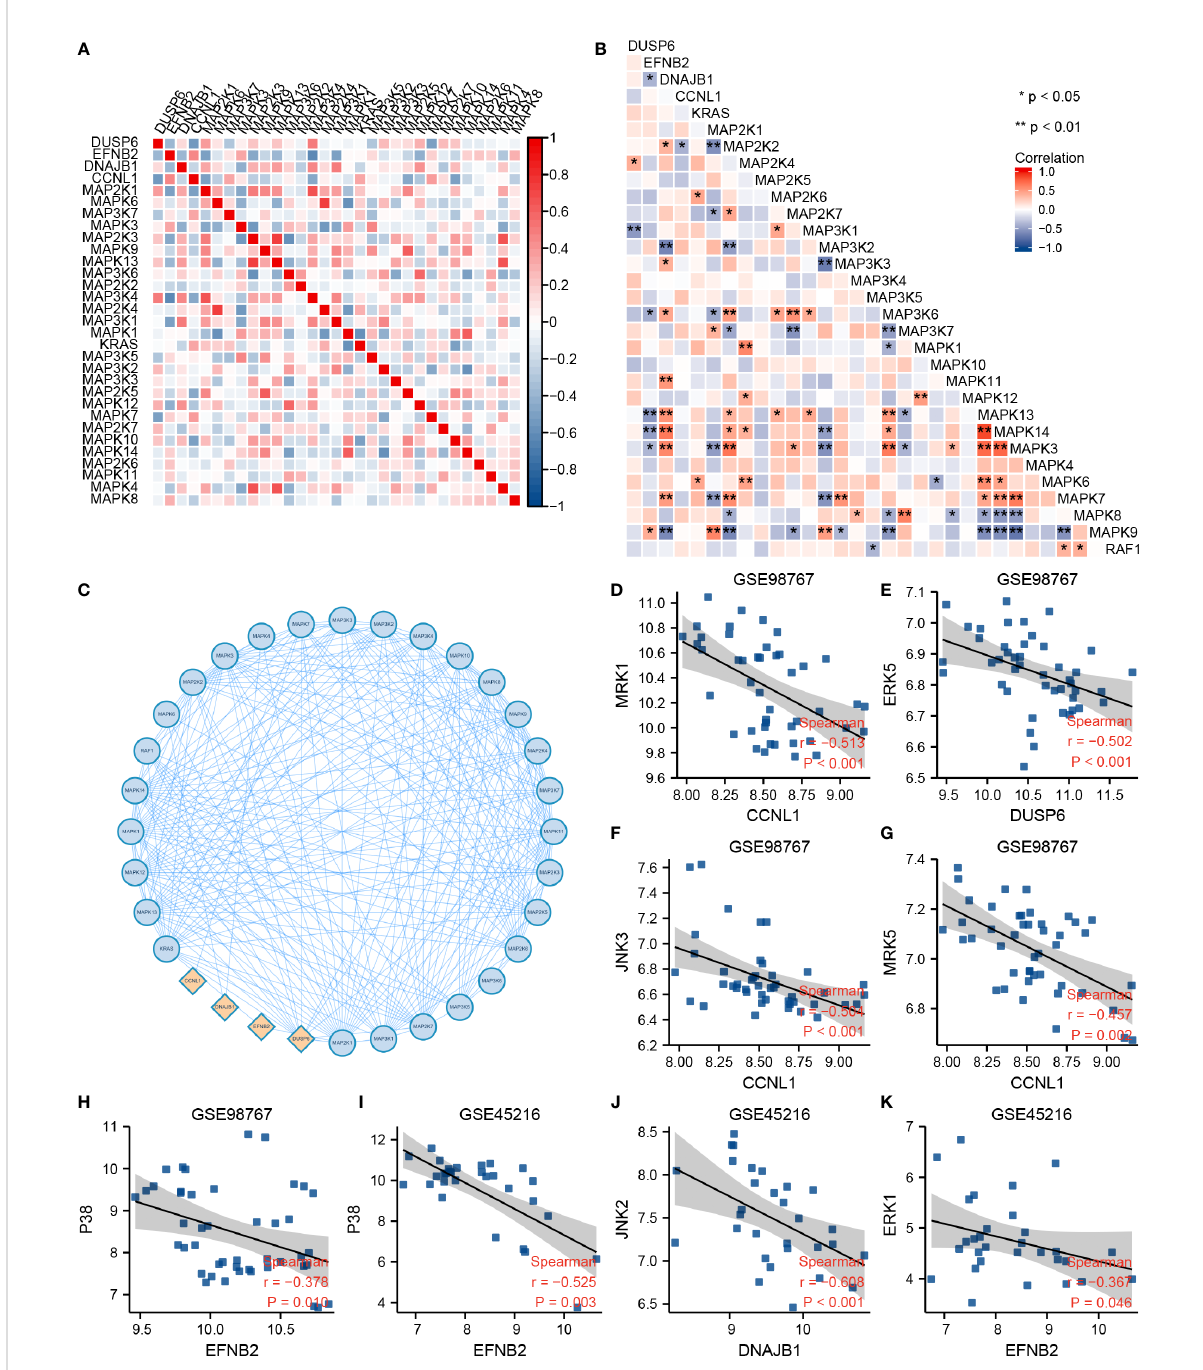
FIGURE 3 Correlation analysis between DUSP6, EFNB2, DNAJB1, CCNL1, and MAPK pathway. (A) A heatmap of correlative coef fi cients between four cSCC-PDT genes and signi fi cant MAPK genes in GSE98767. (B) A heatmap of correlative coef fi cients between four cSCC-PDT genes and signi fi cant MAPK genes in GSE45216. (C) The PPI network of four cSCC-PDT genes and signi fi cant MAPK genes. ( D – K ) Spearman analysis of four cSCC-PDT genes and MAPK pathway